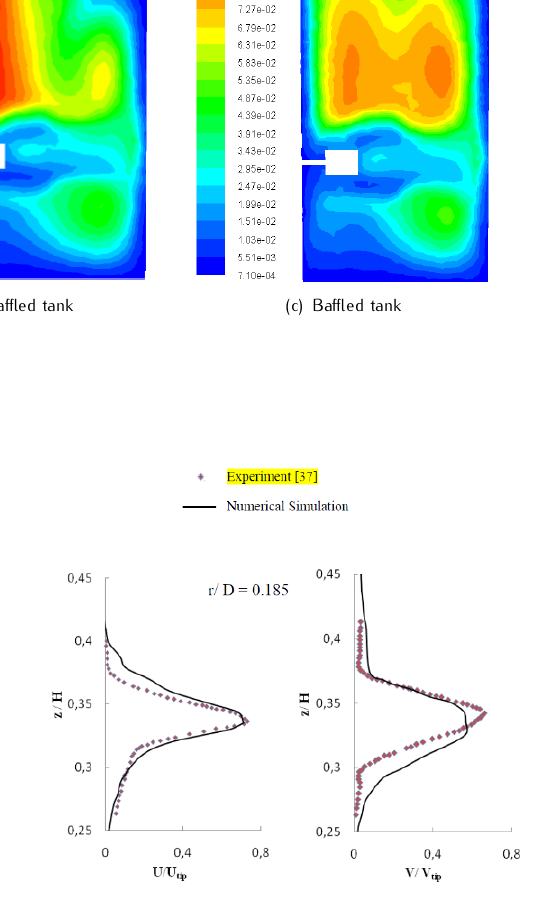
Figure 14. Axial profiles of the radial and the tangential component of the velocity.